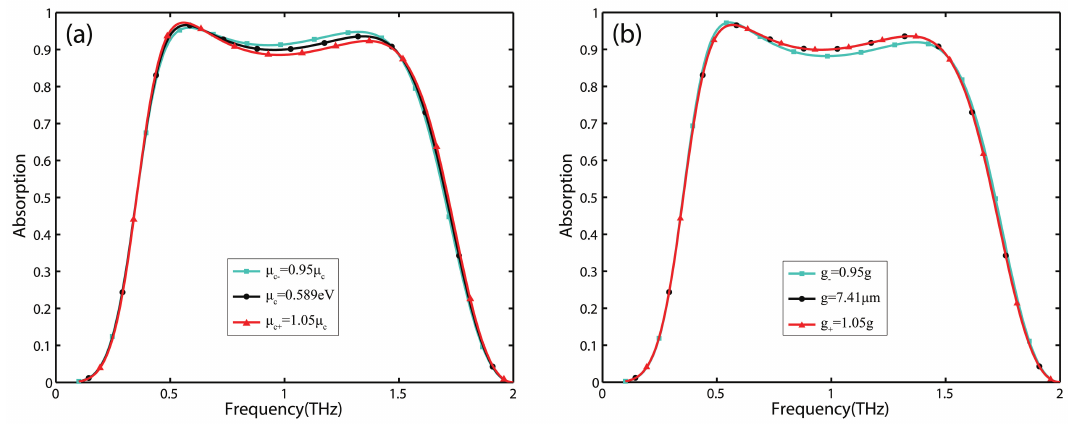
Figure 6. The absorption spectrum of the absorber calculated by full-wave simulation for: ( a ) three different Fermi energy of graphene patches. ( b ) three different gaps of graphene